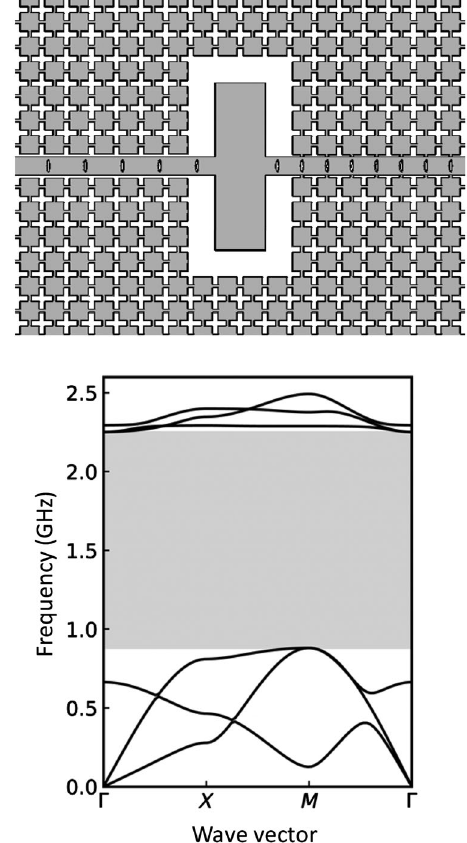
FIG. 4. Top: The building block of a phononic network embedded in a square phononic crystal lattice with a period of 4 μ m. The side length of the squares is 3 μ m. The connecting bridges have a length of 1 μ m and width of 0 . 4 μ m. Bottom: Phononic band structure of the 2D lattice. Only symmetric modes are